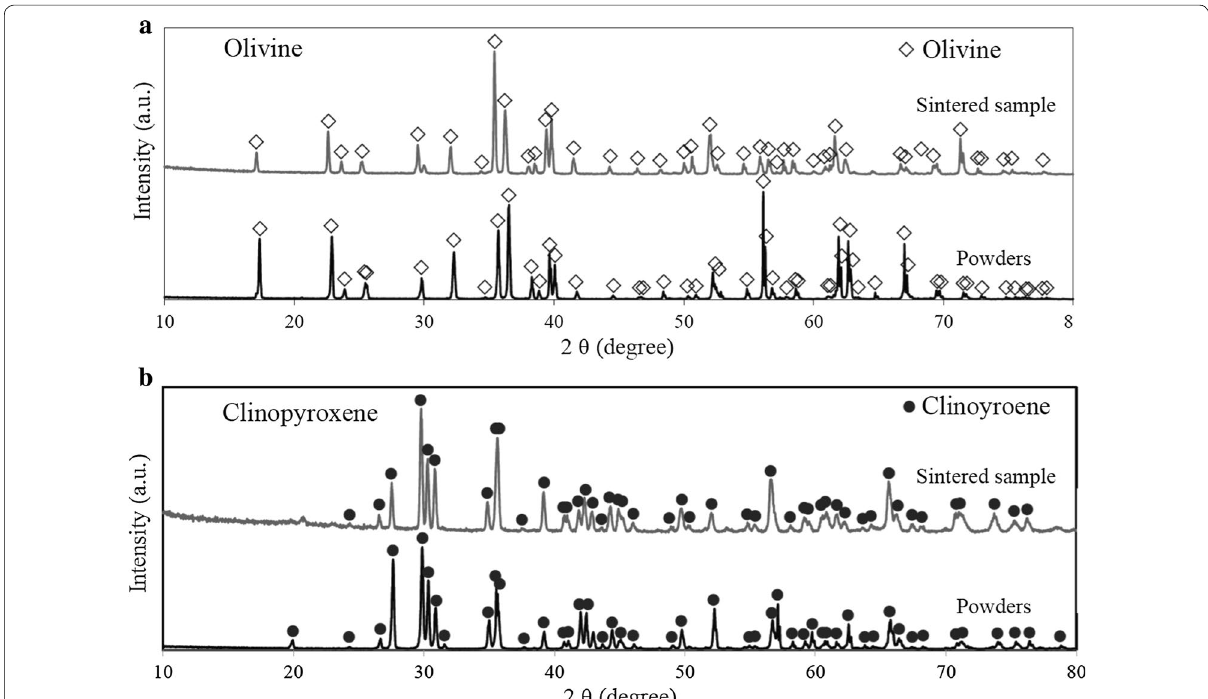
Fig. 3 X-ray diffraction patterns from the mineral powders and sintered samples of a olivine and b clinopyroxene from powders milled with etha- nol. Olivine and clinopyroxene samples were sintered at 1300 and 1280 °C, respectively. The XRD patterns of both sintered samples did not exhibit graphite peaks (e.g., at a 2 θ value of